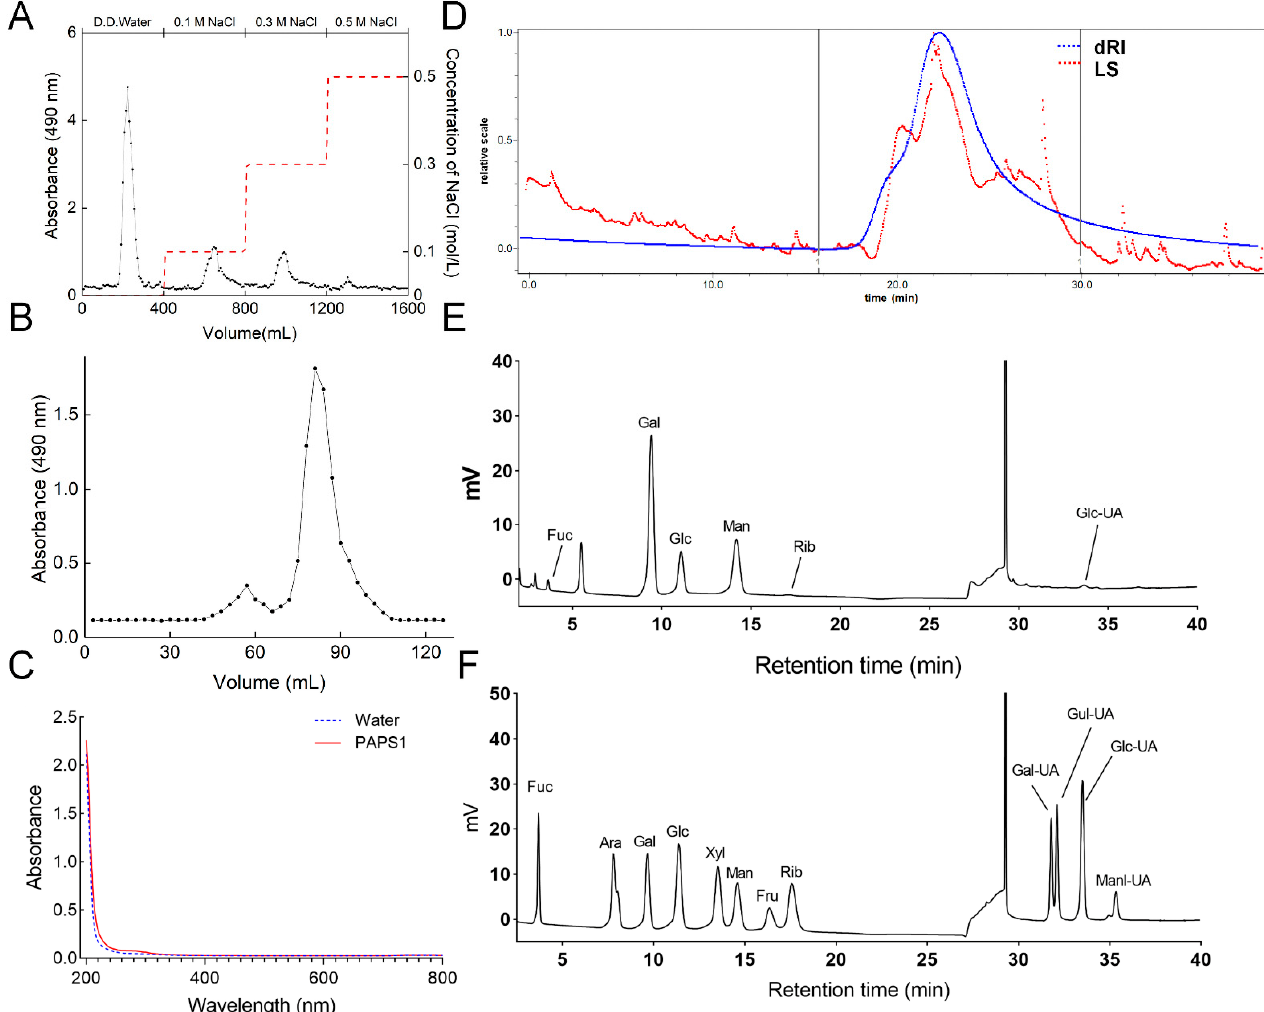
Figure 1. ( A ) Elution profile of the extract of PA fruiting bodies using DEAE-52. Red dotted line represented the 0.1, 0.3 and 0.5 M NaCl solutions, respectively. ( B ) Elution profile of PAPS1 purified by Superdex 200 prep grade column. ( C ) The UV-Vis spectrum of PAPS1 in the wavelength range of 200 to 800 nm. ( D ) Molecular weight analysis of PAPS1. The blue line is the response of the refractive index detector, and the red line is the response of laser light scattering. The calibration curve of pullulan markers is shown in the chromatogram. ( E ) Monosaccharide composition of PAPS1. ( F ) Standard monosaccharide mixture. PA, Pleurotus abieticola; PAPS1, water-soluble PA polysaccharides; dRI, differential refractive index; LS, light scattering, Fuc, fucose; Ara, arabinose; Gal, galactose; Glc, glucose; Xyl, xylose; Man, mannose; Fru, fructose; Rib, ribose; Gal-UA, galacturonic acid; Gul-UA, guluronic acid; Glc-UA, glucuronic acid; Manl-UA, Mannuronic acid.